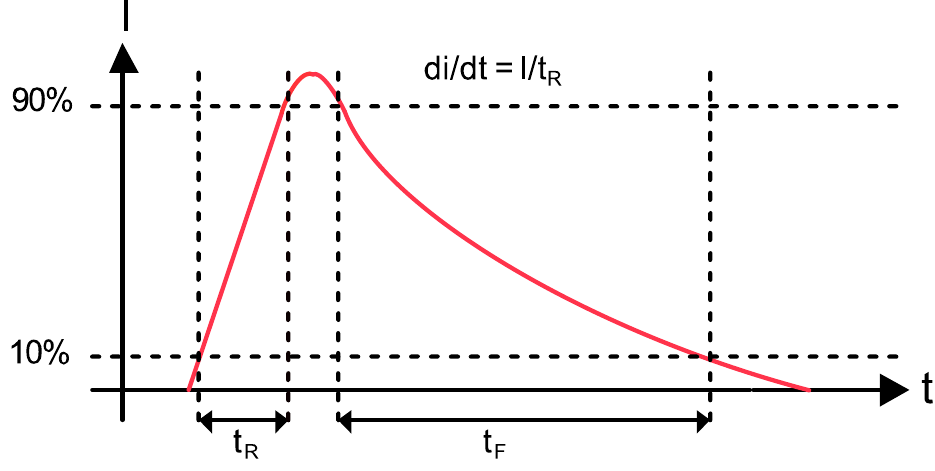
Figure 2. A PD current pulse across an HV insulation void. Detecting and monitoring PD can give an indication of the current condition of the fault and allows for any changes in the condition to be critically assessed over time. Indication that a fault is worsening allows for action to be taken before total failure